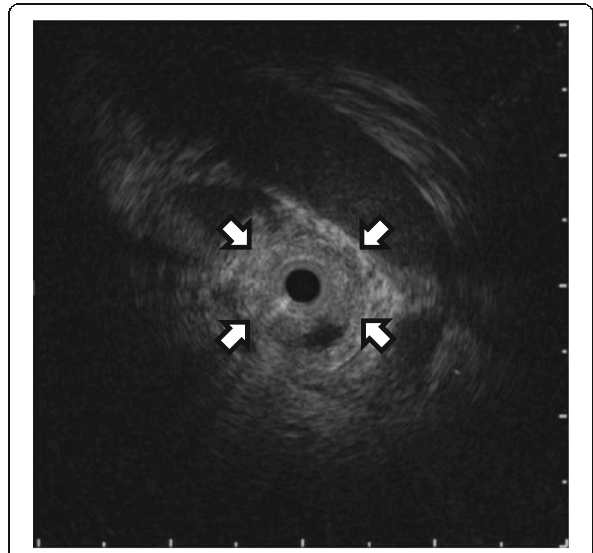
Fig. 4 Intraductal ultrasonography (IDUS) findings. Intraductal ultrasonography (IDUS) suggested the tumor (arrow) was located in the bile duct wall